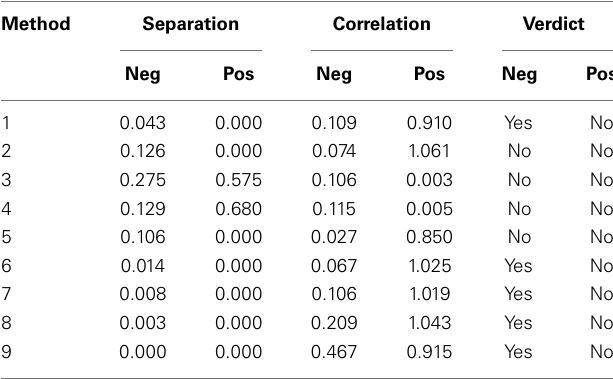
Table 1 | Summary of results of Mann–Whitney tests for Renyi entropy calculated using nine different methods of estimating probabilities .